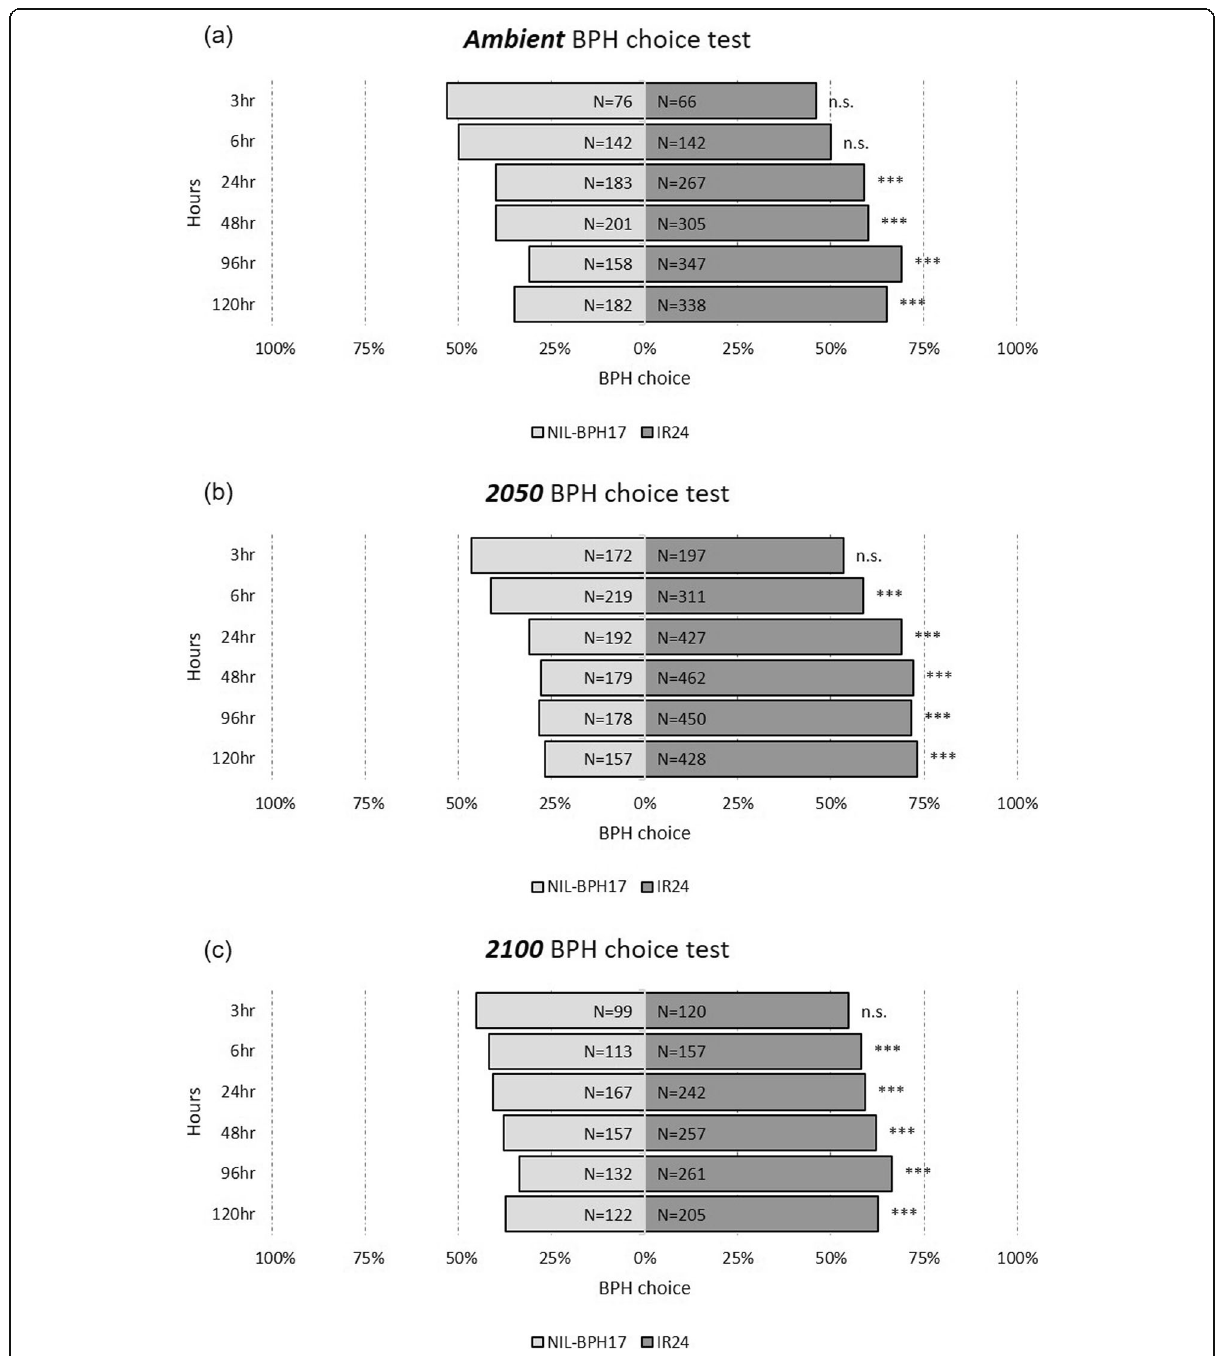
Fig. 7 The choice test of N. lugens nymphs on IR24 and NIL- BPH17 under different environments. a Ambient . b 2050 . c 2100 . Asterisks indicate differences between IR24 and NIL- BPH17 as: *** P < 0.001; n.s. means